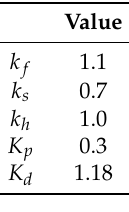
Table 2. Control